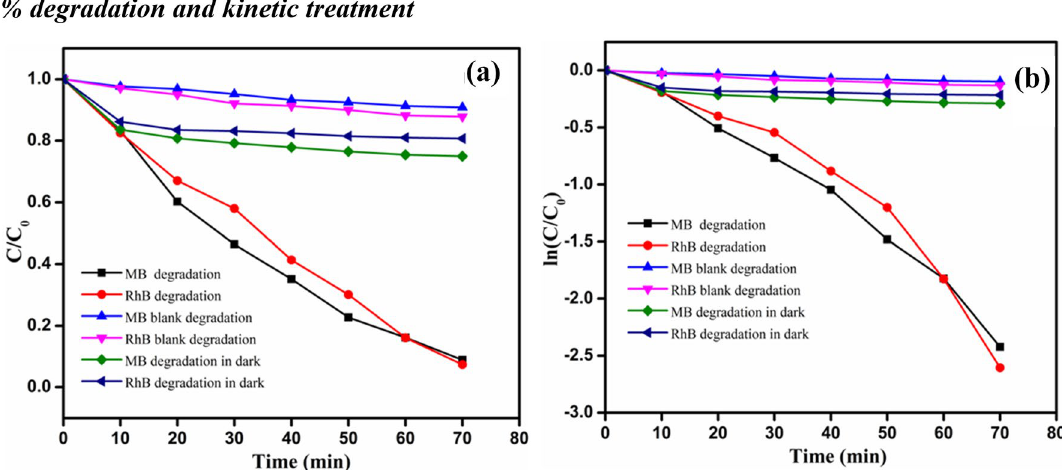
Fig. 13 Degradation kinetics of MB and